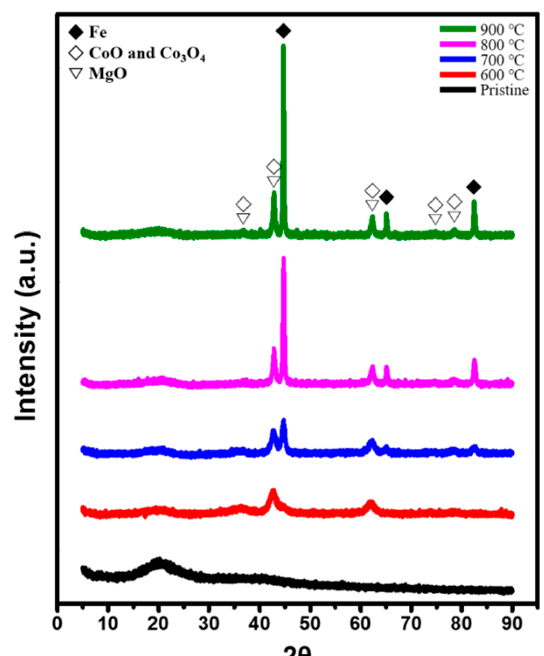
Figure 2. X-ray Diffraction (XRD) analysis of Fe–Co/MgO catalyst as various reduction temperature.